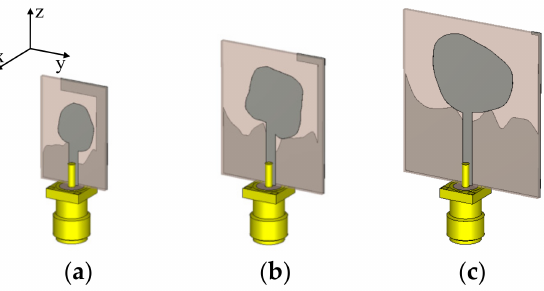
Figure 9. In-scale visualizations of the optimized antenna structures ( a ) x 1.20* , ( b ) x 5.20 * , and ( c ) x 9.12*